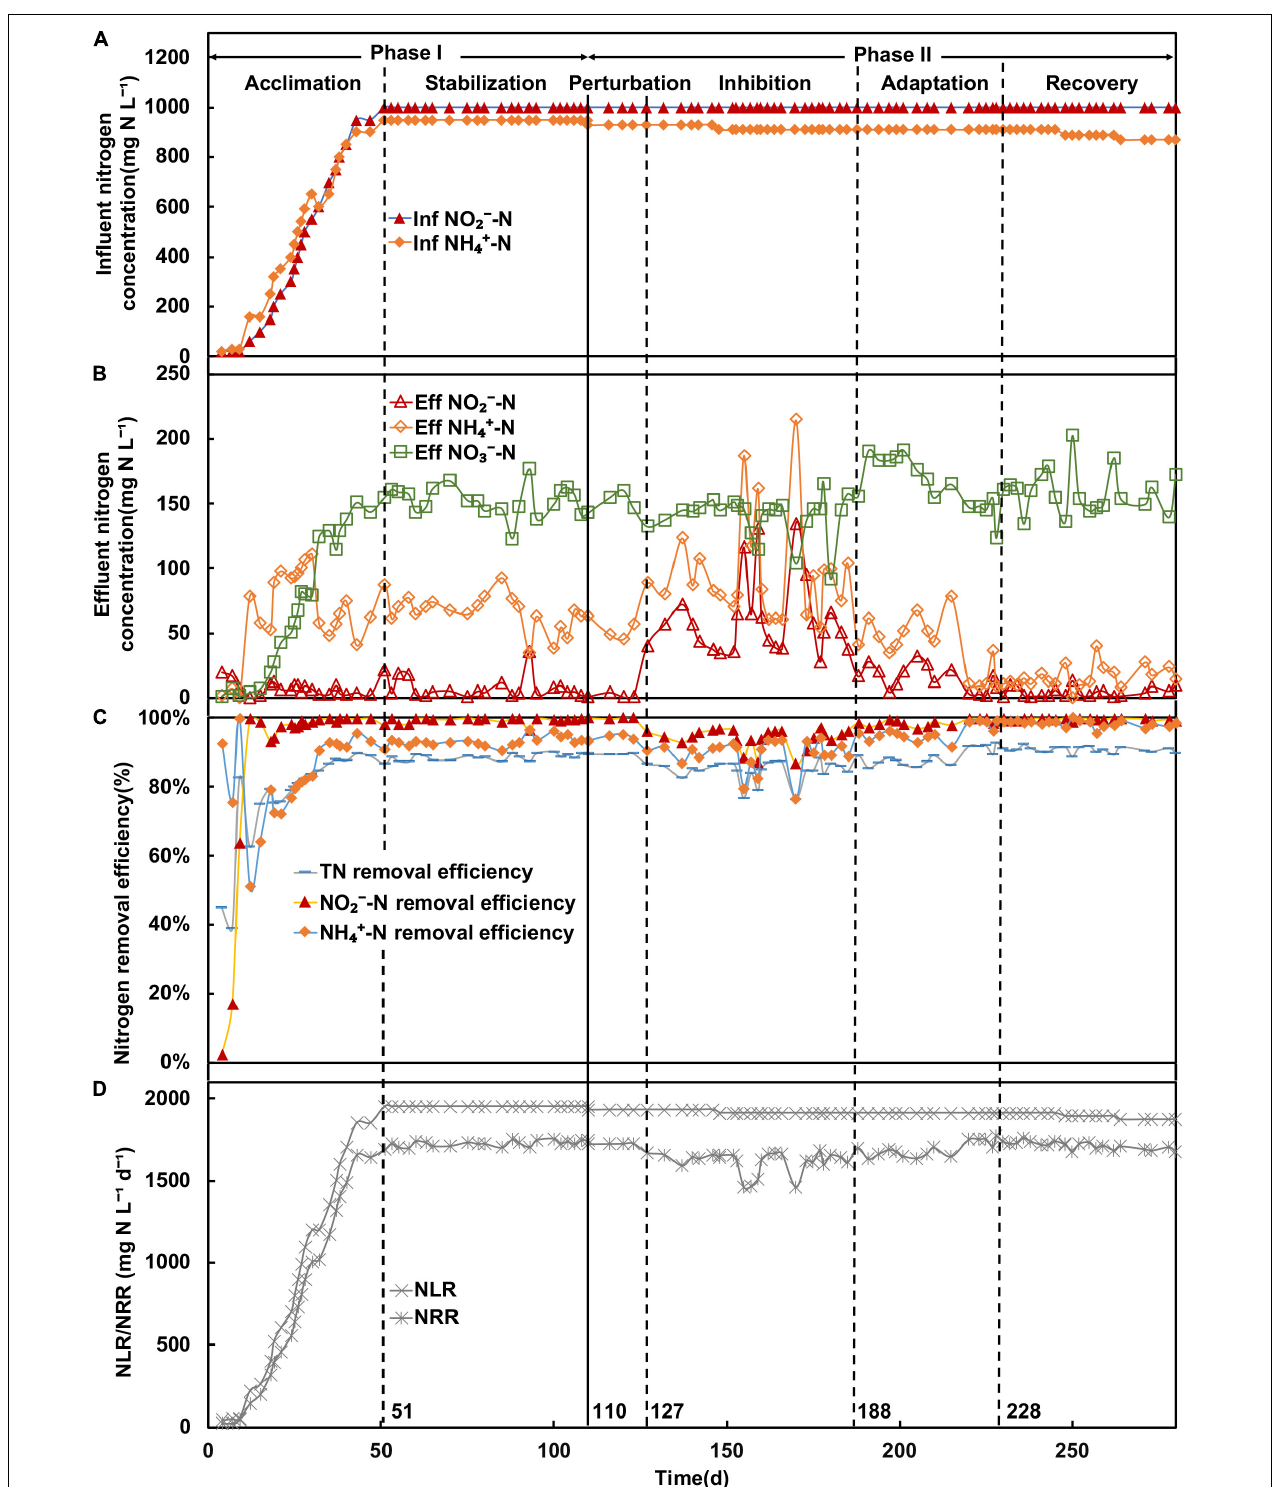
FIGURE 1 | Performance of anammox membrane bioreactor; (A) concentration (mg N L − 1 ) of influent ammonium (NH 4 + -N) and nitrite (NO 2 − -N); (B) concentration (mg N L − 1 ) of effluent ammonium, nitrite, and nitrate (NO 3 − -N); (C) removal efficiency (%) of ammonium, nitrite, and total nitrogen (TN); (D) nitrogen removal rate (NRR) and nitrogen loading rate (NLR) (mg N L − 1 day − 1 ).